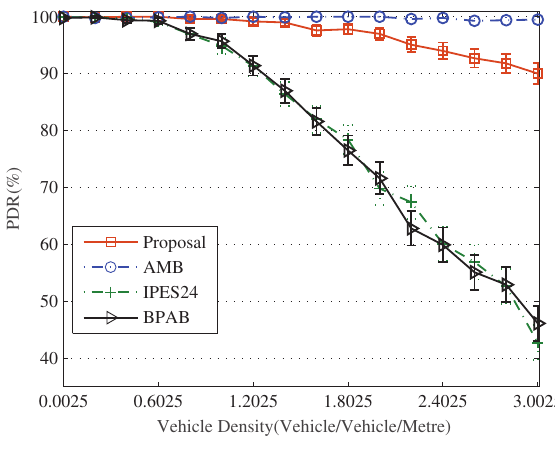
Figure 12. Comparison of